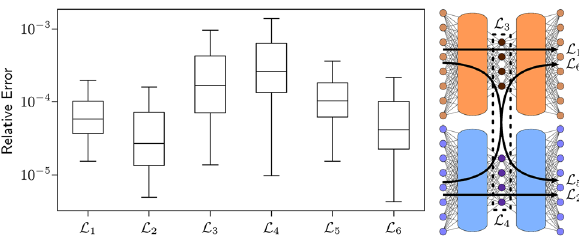
Figure 8. Two-dimensional Poisson model performance summary. Distribution of loss values are shown for every sample in the test data set. Model loss functions are minimized during training, making them a natural metric to use for summarizing